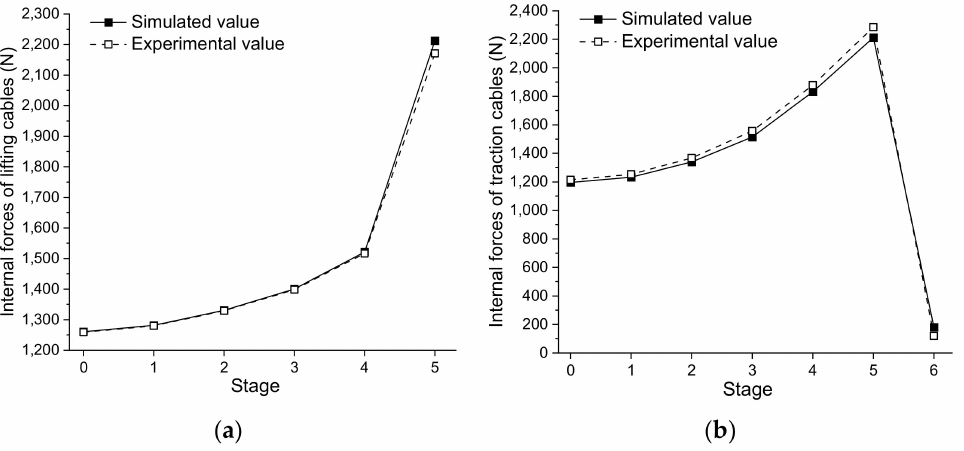
Figure 19. Internal forces of tooling cables during construction. ( a ) Lifting cable; ( b ) Traction cable.